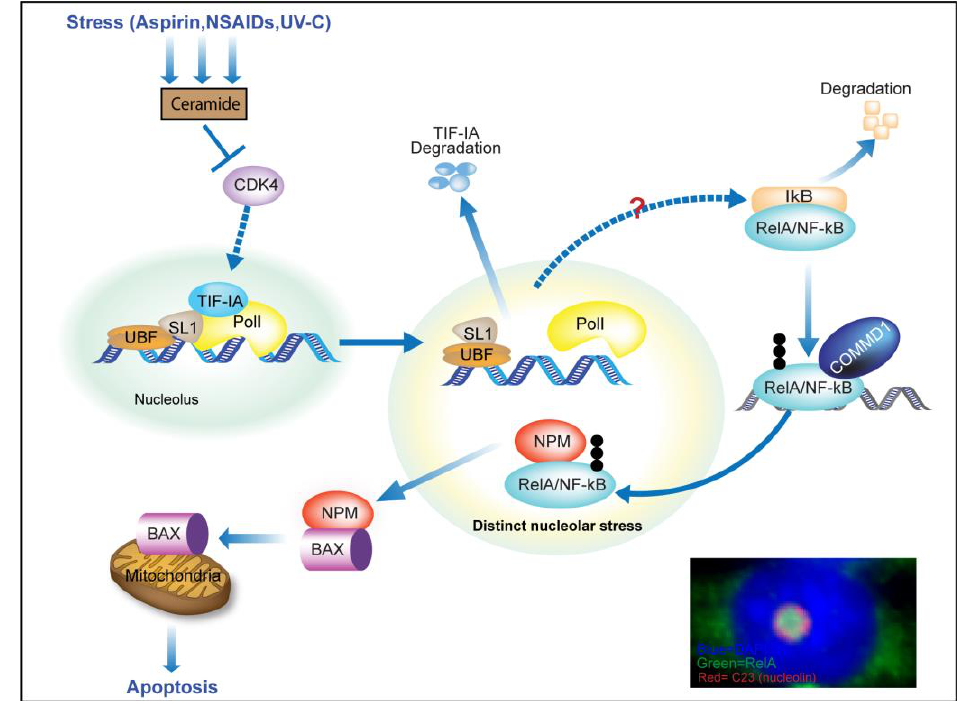
Figure 3. TIF-IA-NF-kB-nucleololar stress response. When cells are exposed to a variety of specific stresses, ceramide is generated leading to inhibition of CDK4. This inhibition induces degradation of TIF-IA (in a manner dependent upon UBF and p14ARF), which in turn causes increased nucleolar size, gross changes in nucleolar morphology and degradation of IkB. IkB degradation allows RelA/NF-kB to translocate into the nucleus and recruit a COMMD1 dependent ubiquitin ligase complex. Ubiquitination of RelA by this specific complex targets the protein to nucleoli, where it binds nucleophosmin (NPM), causing this protein to relocate out of nucleoli to the cytoplasm, where it is free to bind BAX and transport BAX to the mitochondria to mediate apoptosis. The signalling network(s) that links altered nucleolar function to IkB degradation is unknown. Inset: Immunomicrograph showing enlarged segregated nucleoli and nucleolar accumulation of RelA in response to aspirin (5mM, 16h). DAPI depicts DNA.